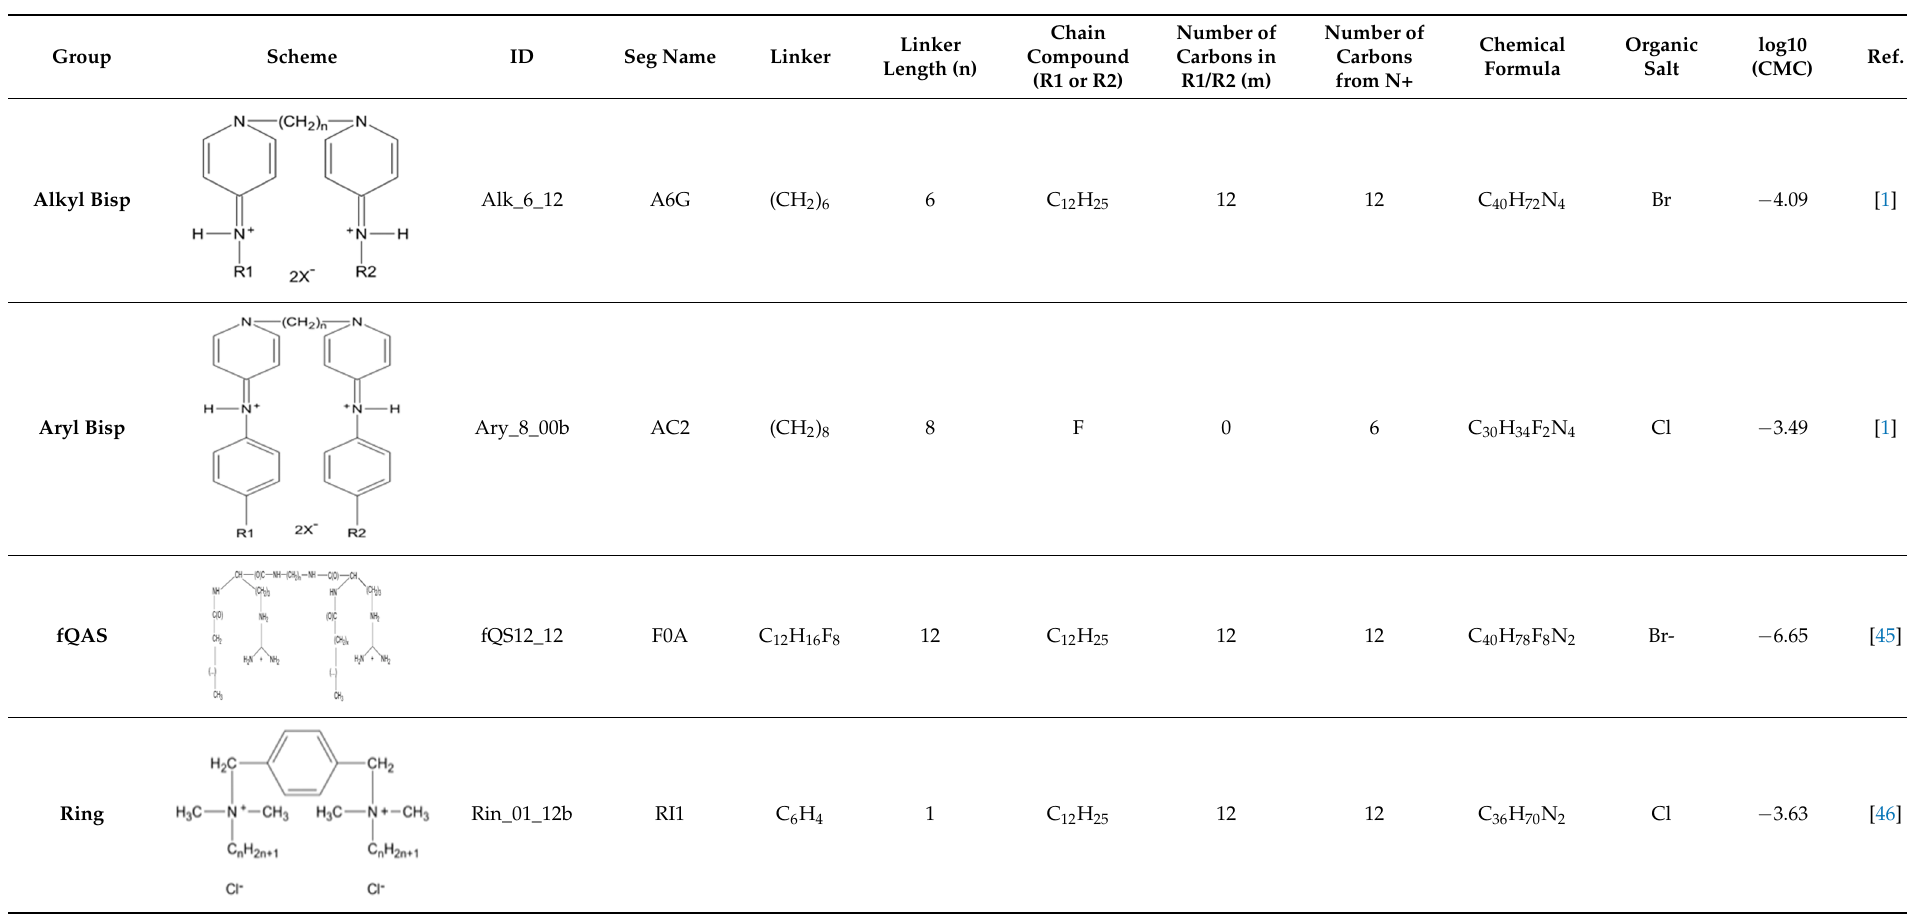
Table 1. Representation of selected modelled molecules from detailed base included in Supporting Materials.